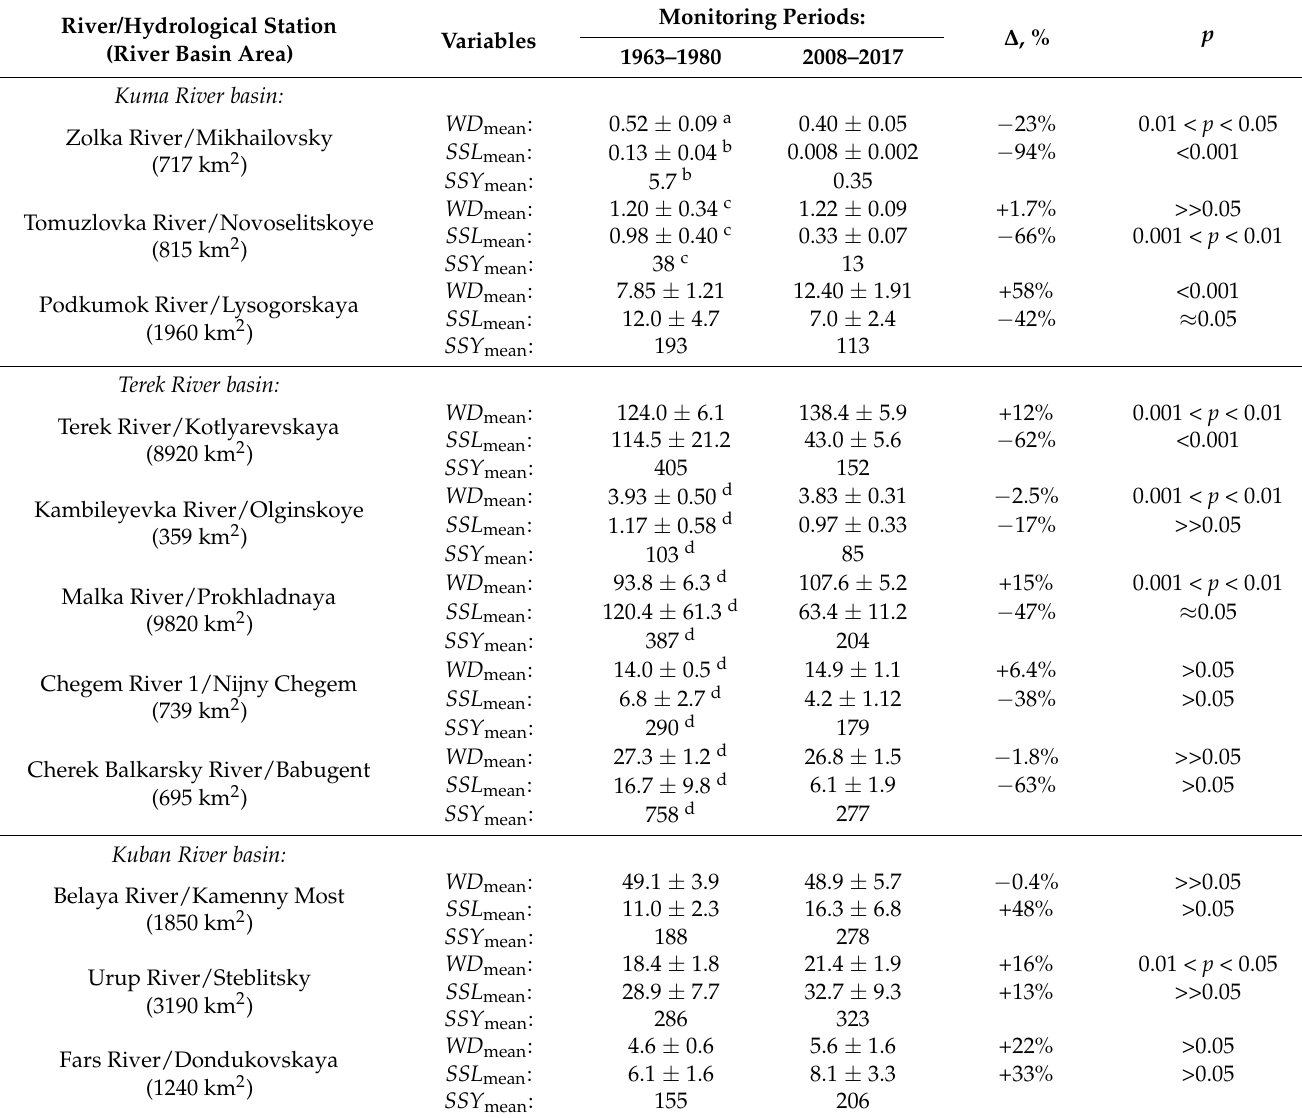
Table 2. Period-to-period changes in mean annual water discharge ( WD mean , m 3 s − 1 ), mean annual suspended sediment load ( SSL mean , kg s − 1 ), and annual suspended sediment yield ( SSY mean , Mg km − 2 y − 1 ) of some analyzed rivers of the North Caucasus region (see Table 1; Figure 1) during 1963–2017 ( ∆ —relative